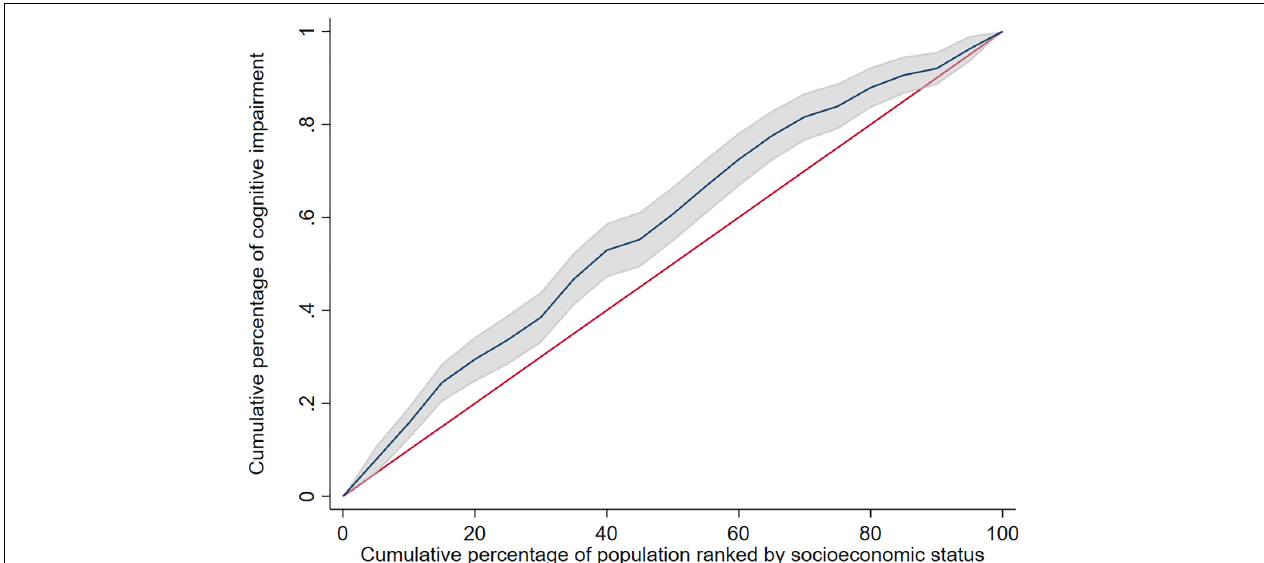
FIGURE 1 | Concentration curve of cognitive impairment. The shadow around the curve represent